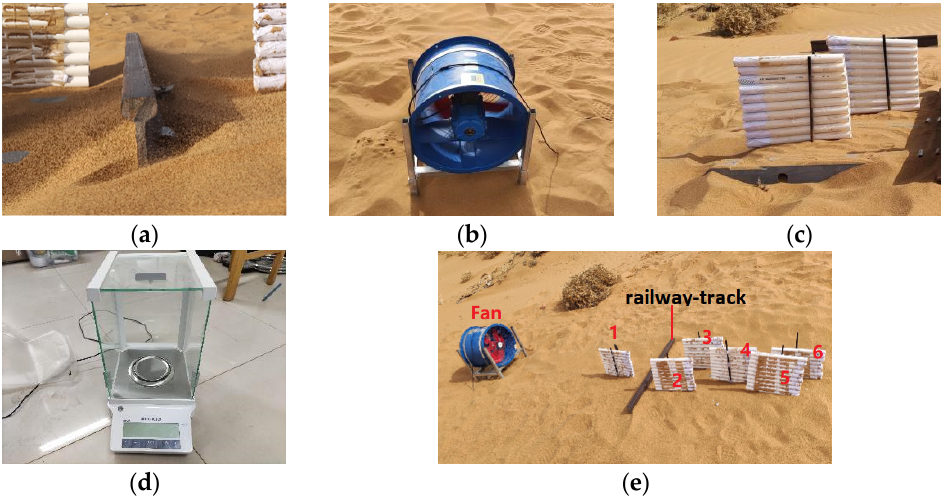
Figure 2. Sketches of the field experiment. ( a ) the track; ( b ) axial fan; ( c ) sediment collecting device; ( d ) electronic balances; ( e ) arrangement of experimental equipment.